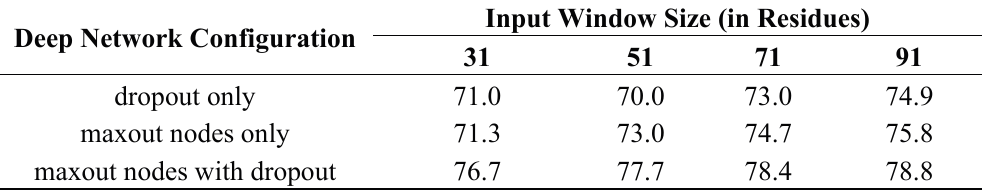
Table 7. AUC for disorder predictions by input window size on the CASP10